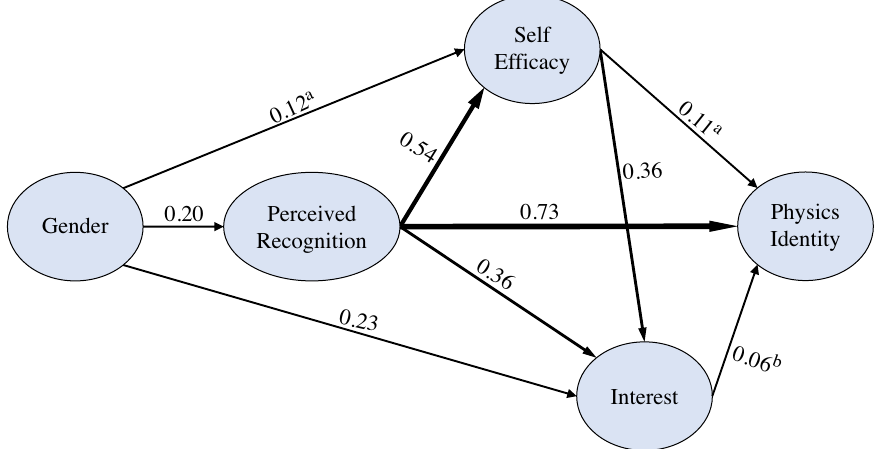
FIG. 3. Result of the path analysis part of the SEM with the relationship between gender and physics identity being mediated through perceived recognition, self-efficacy, and interest for physics 2. The gender variable was coded as 0 for women and 1 for men. The line thickness qualitatively denotes the relative magnitude of the standardized regression coefficients β shown. All p values for β are indicated by no superscript for p < 0 . 001 “ a ” for 0 . 001 ≤ p < 0 . 05 , and “ b ” for p ≥ 0 . 05 (nonsignificant). Gender does not directly predict physics identity.